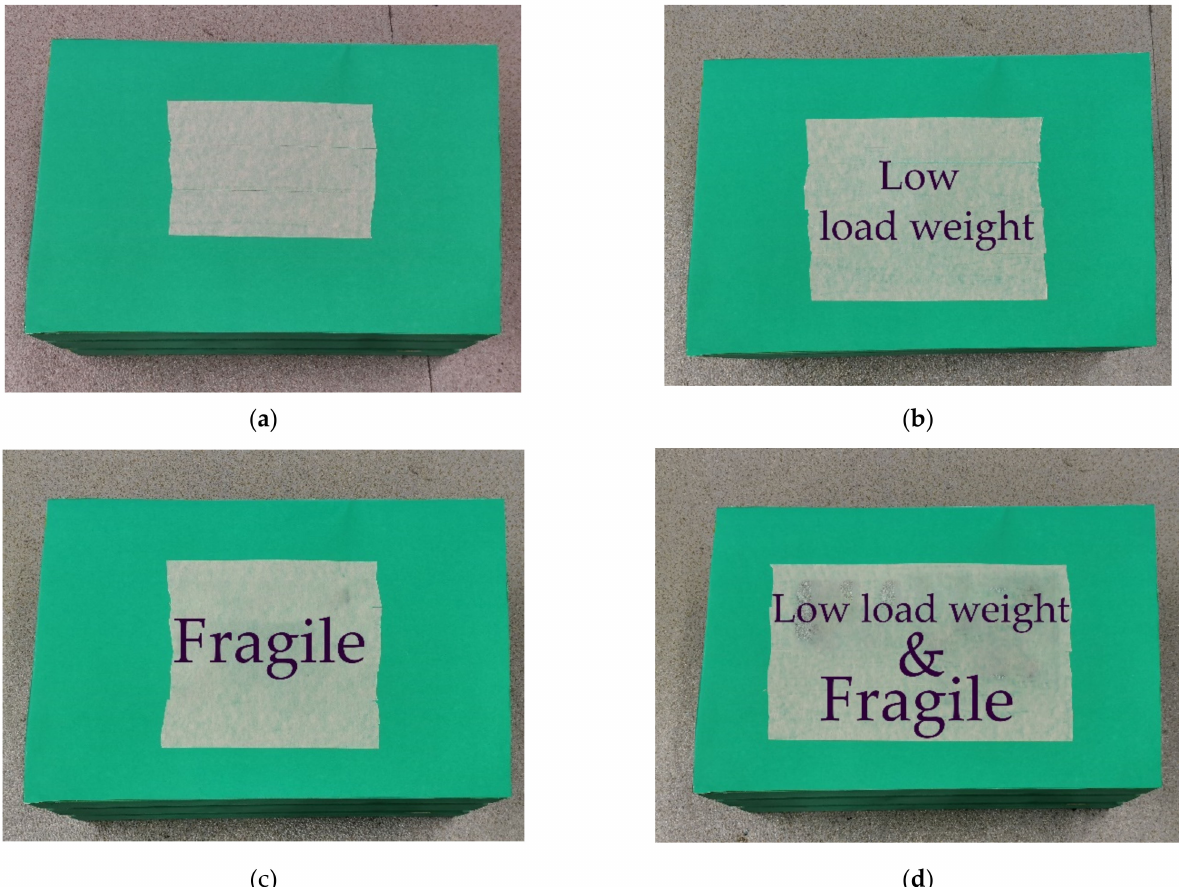
Figure 2. The lifting boxes used in each load knowledge condition. ( a ) NK: no knowledge; ( b ) WK: weight known; ( c ) FK: fragile material known; ( d ) WFK: weight and fragile material